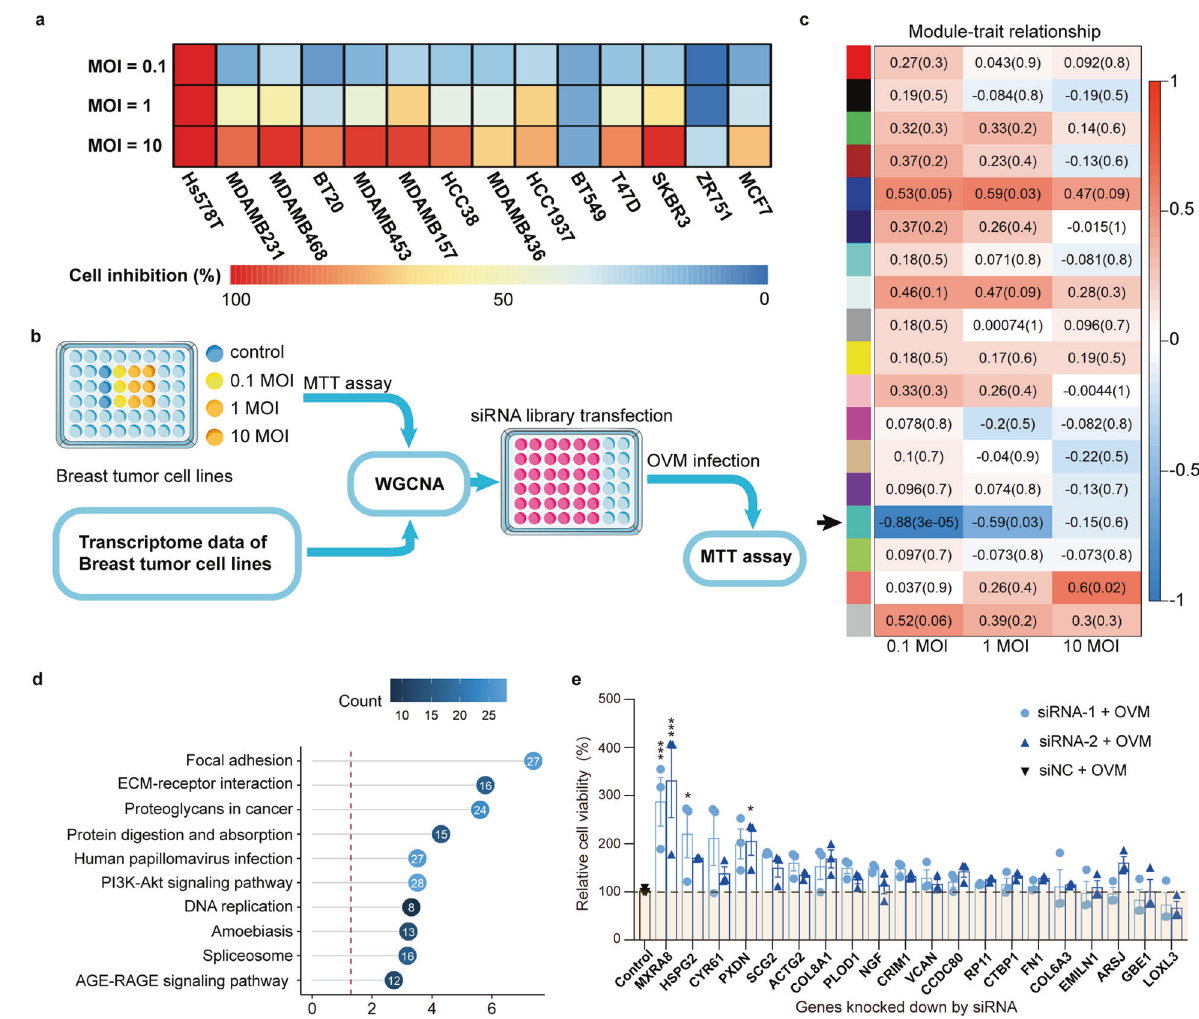
Fig. 1 The therapeutic ef fi cacy of OVM is related to the tumor expression level of MXRA8. a Cell inhibition rates in 14 breast tumor cell lines treated with OVM (MOI = 0.1, 1, or 10) for 72 h. b An outline of analysis protocol. Firstly, tumor cells were seeded in 48-well plates and treated with OVM in respective MOI for 72 h and detected by MTT. Secondly, transcriptome data of 14 breast tumor cell lines were obtained from Broad Institute Cancer Cell Line Encyclopedia (CCLE) and analyzed by WGCNA. Lastly, secondary screen was further conducted to identify genes associated with OVM-induced oncolysis. c Spearman ’ s correlation coef fi cient between the co-expression modules (shown as the colored boxes) and the cell viability in escalating MOI of OVM analyzed by WGCNA. d The major pathways enriched in genes of turquoise co- expression module determined by KEGG analysis. e Hs578T cells transfected with siRNAs targeting the top 20 differentially expressed genes were incubated with OVM (0.1 MOI) and analyzed for cell viability by MTT (three experiments, n = 3; one-way ANOVA; mean ± s.d.). * P < 0.05; ** P < 0.01; *** P < 0.001 1 MOI, R = − 0.59). Further analysis demonstrated that genes one type of tumor revealed a challenge for OVM therapy posed by within the turquoise module were enriched in focal adhesion tumor heterogeneity. Moreover, we found the different levels of and ECM-receptor interaction (Fig. 1d). To further identify genes sensitivity to OVM in these cell lines had no obvious correlation associated with OVM-induced oncolysis, we conducted an RNAi with ZAP, endoplasmic reticulum to nucleus signaling 1 (ERN1), screen to target the top 20 genes in the turquoise module and ras homolog family member (RHOQ) expression, which are (Supplementary Fig. 1e, Supplementary Table 1). siRNA- associated with OVM viral replication (Supplementary Fig. transfected Hs578T cells were either mock-infected or infected with OVM at 0.1 MOI and measured for cell viability by MTT assay (Fig. 1b, Supplementary Fig. 1f). Among these genes, transfecting of siRNA targeting matrix remodeling associated 8 (MXRA8, also called limitrin, ASP3 or DICAM), a membrane protein that normally interacts with α v β integrin, associated with the blood-brain barrier and was recently identi fi ed as an entry receptor for chikungunya virus (CHIKV) 8,15,16 , could signi fi cantly improve cell viability of Hs578T cells under OVM infection (Fig. 1e). These data indicate that MXRA8 could contribute to the oncolytic effect of OVM in breast tumor cells and plays an essential role in OVM ’ s life cycle.